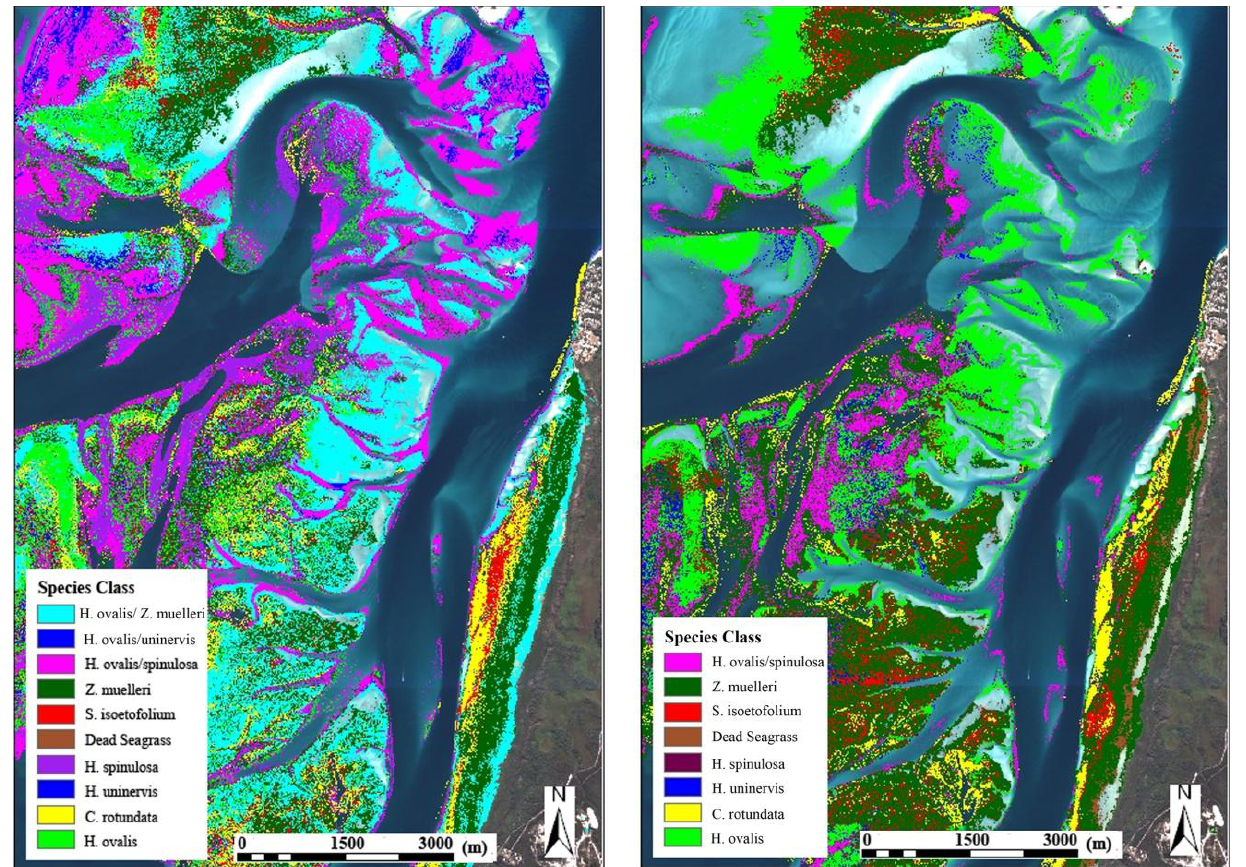
Figure 5. Seagrass species composition map produced for 2004 (left) and 2007 (right)